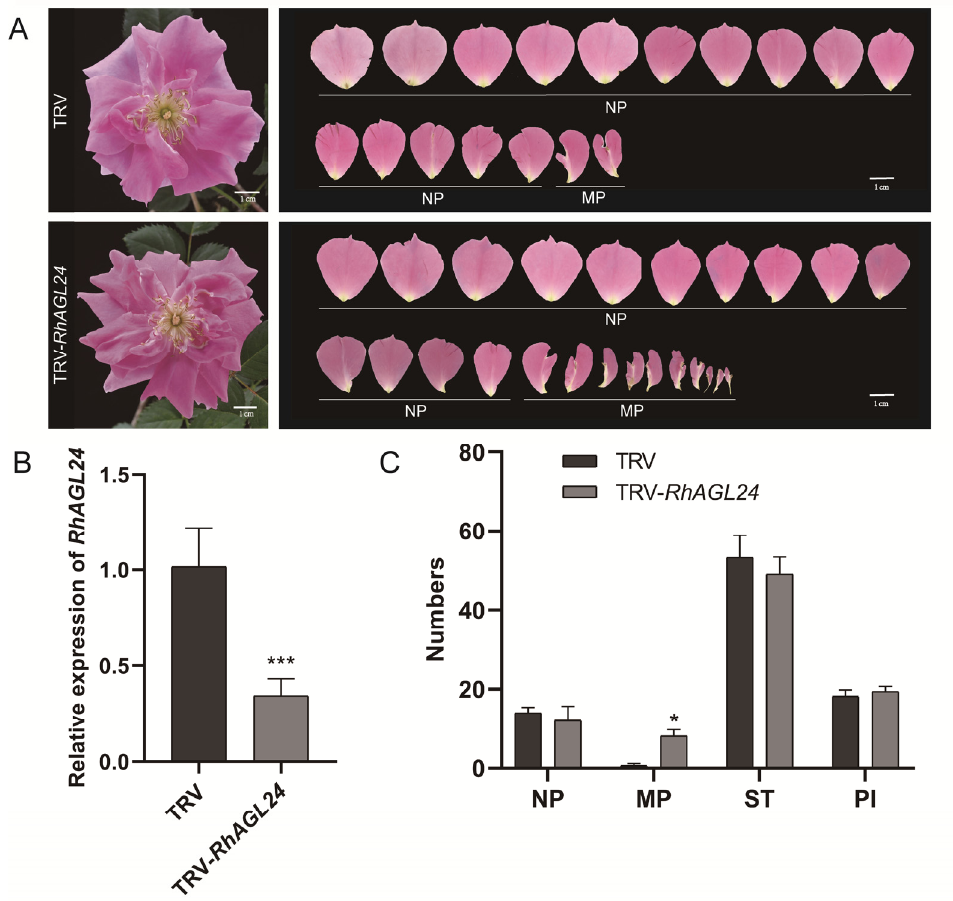
Figure 3. Silencing of RhAGL24 affects the number of petals and stamens. ( A ) Phenotype of TRV and TRV- RhAGL24 strains. ( B ) RhAGL24 expression in RhAGL24 -silenced (TRV- RhAGL24 ) and TRV control plants as determined by qRT-PCR. ( C ) Statistics on the phenotypic data of TRV and TRV- RhAGL24 strains. NP—normal petal; MP—malformed petal; ST—stamen; PI—pistil. All the values are the means ± SD of seven biological replicates. RhUBI2 was used as an internal control. Asterisks indicate statistically significant differences by Student’s t-test (* p < 0.05, *** p < 0.001).